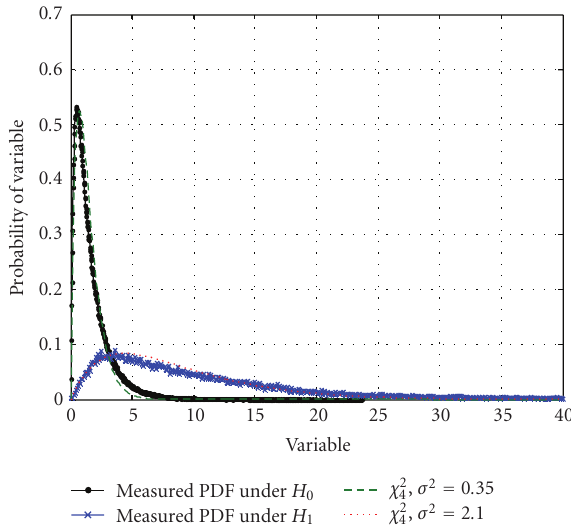
Figure 9: Numerically calculated PDF under H 0 and H 1 states for a moving